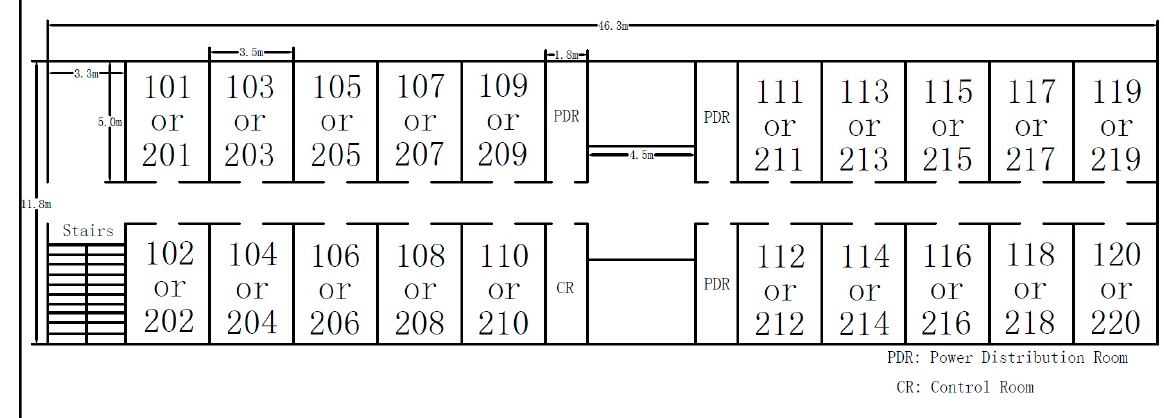
Figure 4. Layout of Yibei Building.